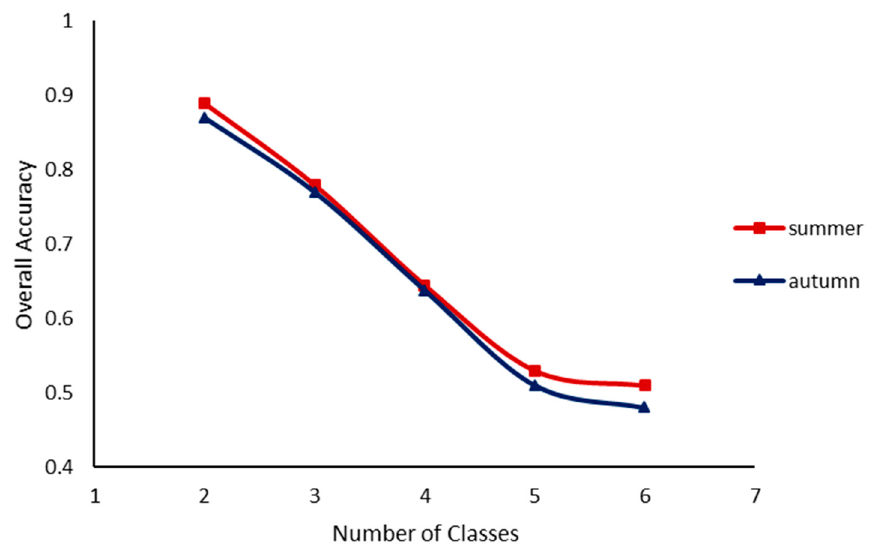
Figure 2. Relationship between number of species/groups and overall accuracy in two seasons. Figure adapted and modified from [72] .